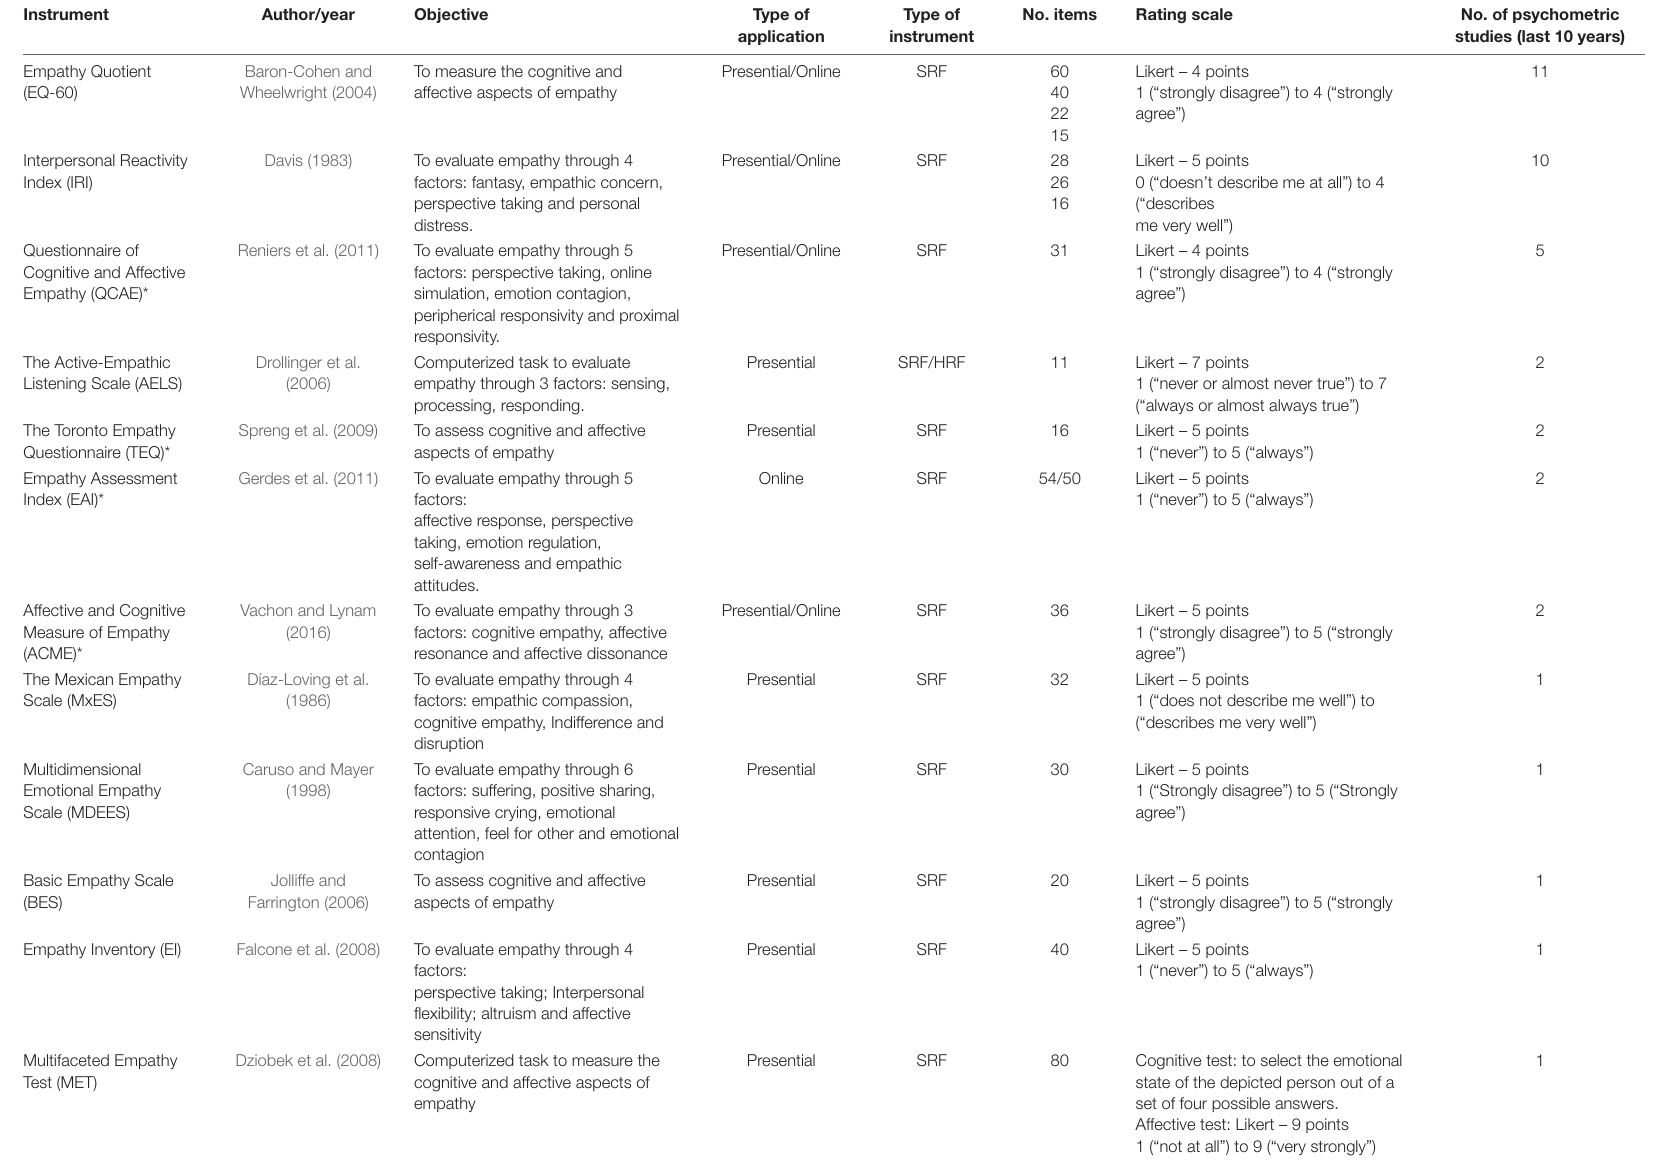
TABLE 1 | Overview of the instruments analyzed to assess general empathic capacity in the general population (ranked from most studied to least studied). Instrument